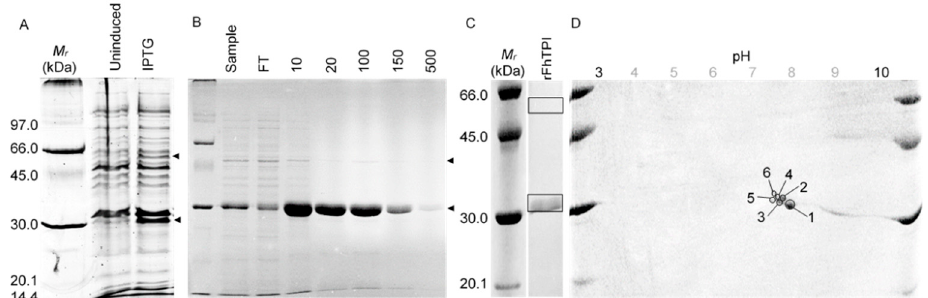
Figure 2. Expression, purification, and proteomic analysis of recombinant Fasciola hepatica triose